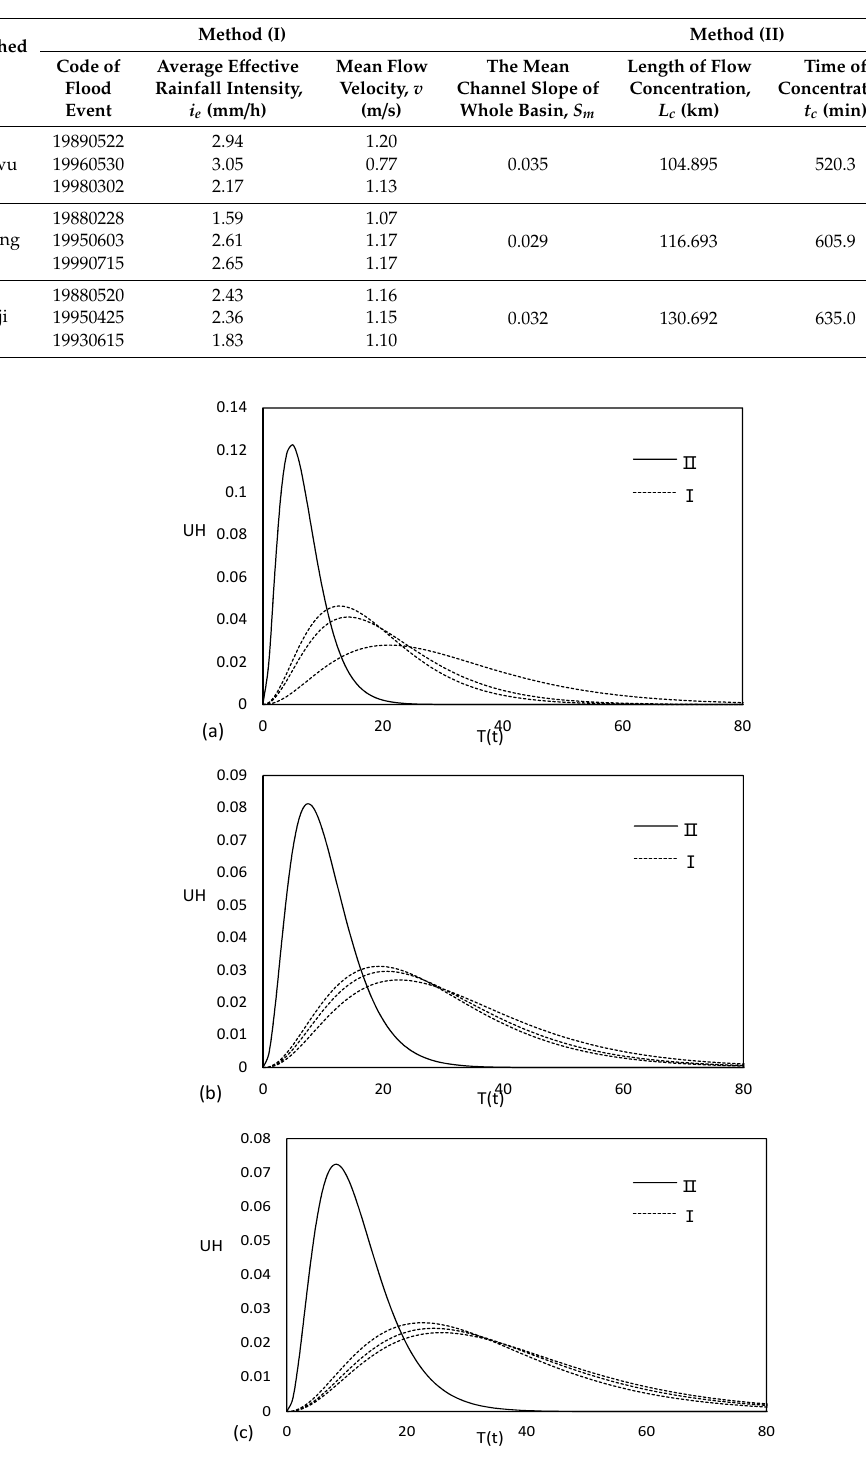
Table 3. Estimation of the average flow velocity in terms of two di ff erent methods (I) is calculated based on the Kirpich formula with the e ff ective rainfall intensity in 3 flood events, and (II) is a path of computing the velocity merely dependent on the geomorphologic characteristics: the channel slope and the length of flow concentration.